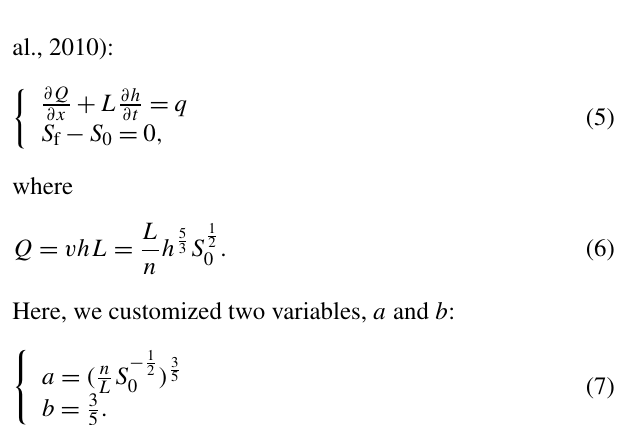
Figure 3. Spatial structure of karst hydrological response units (KHRUs) (Li et al.,